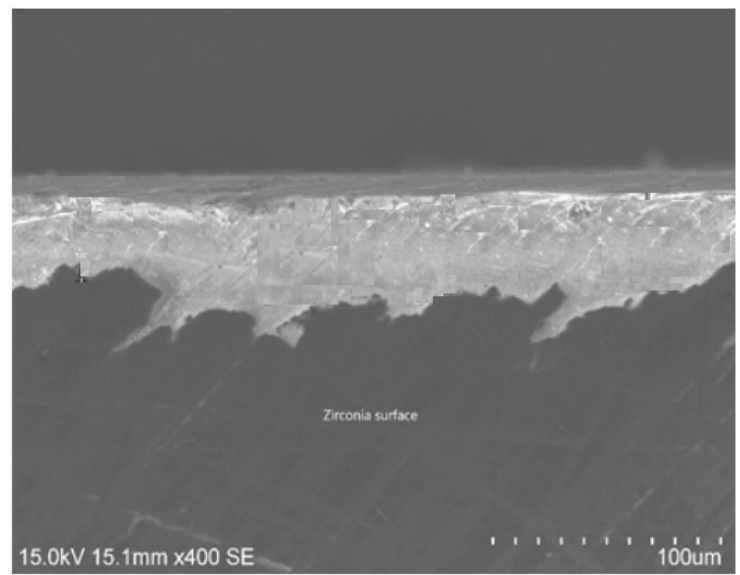
Figure 1. SEM micrograph showing the average thickness of the deposited silica layer on PVD zirconia samples.